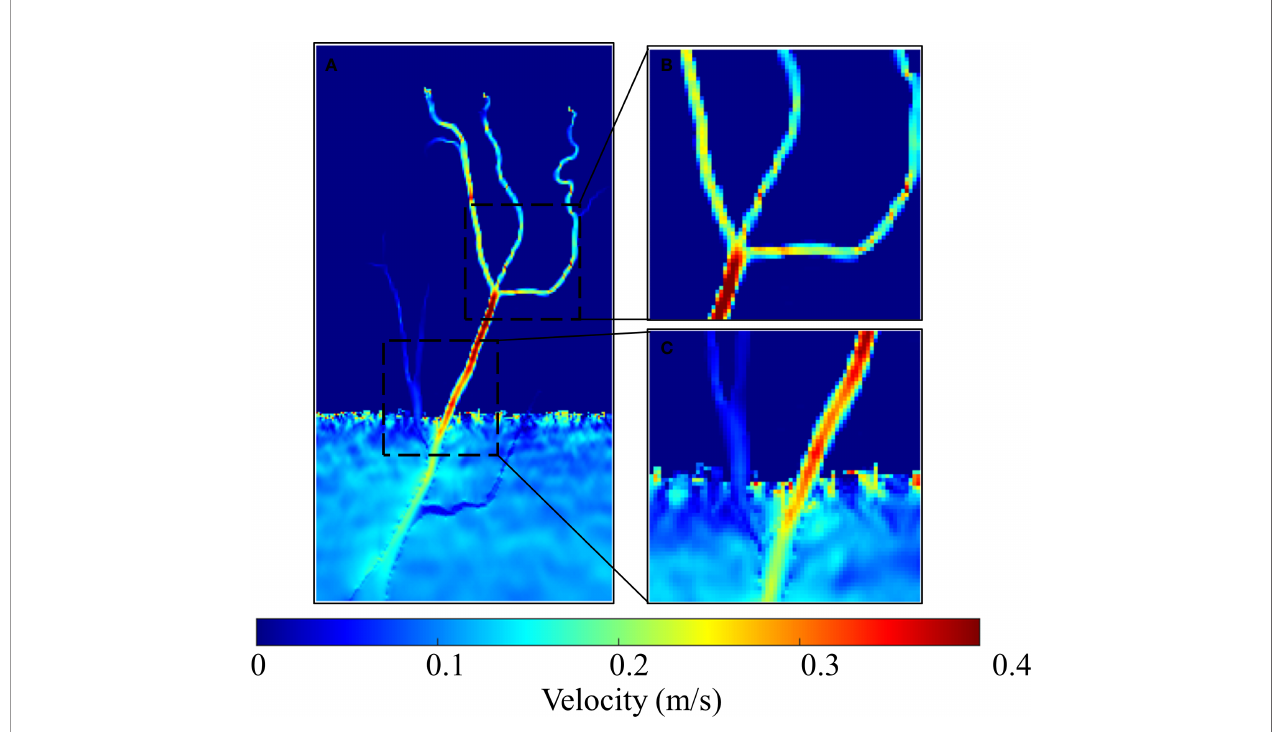
FIGURE 6 | The hydrodynamics simulation results of H(1) during fl ood tide on the 241th Julian day: (A) the whole tidal channel network; (B, C) subregions of tidal channel